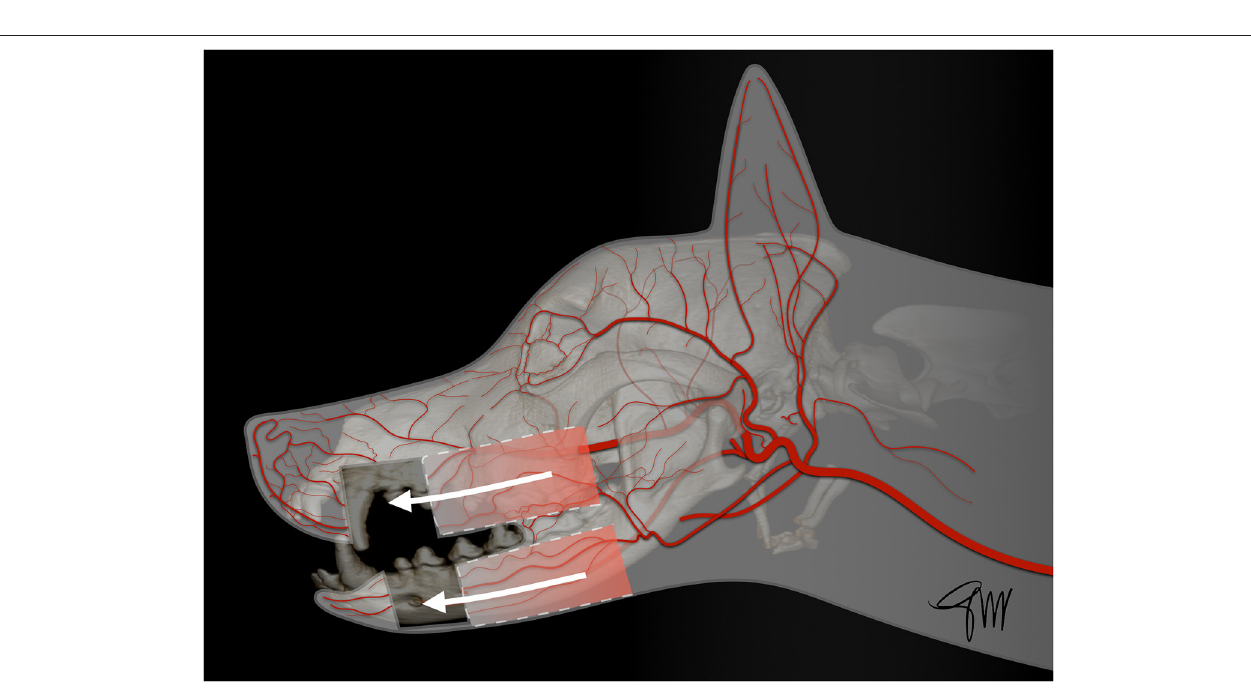
the lips ( rima oris ). This is considered a minor cosmetic change ( Figure 8